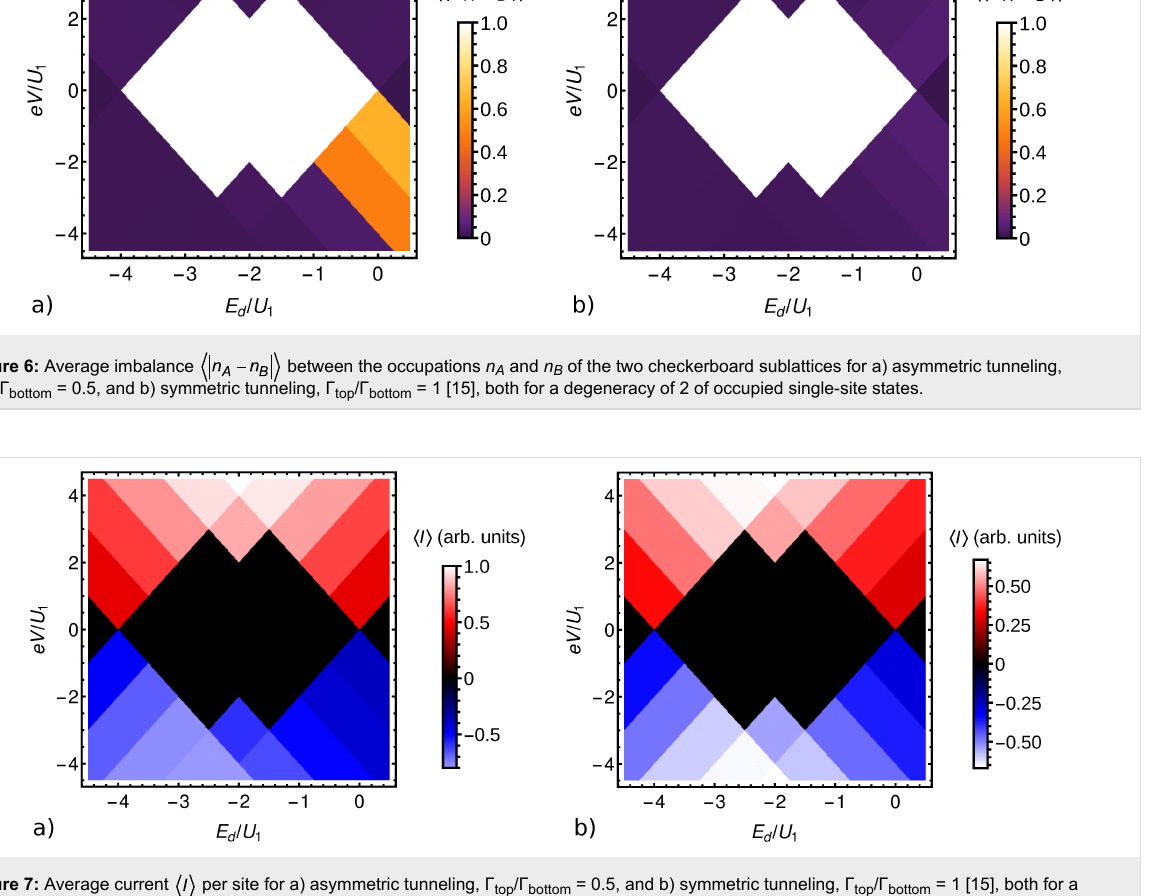
phase. In this phase, tunneling takes place only through one sublattice, which has an average occupation between 0 and 1, while the other sublattice is empty. According to Figure 6a, it occurs for negative bias voltages, which correspond to elec- trons tunneling out of the bottom electrode into the